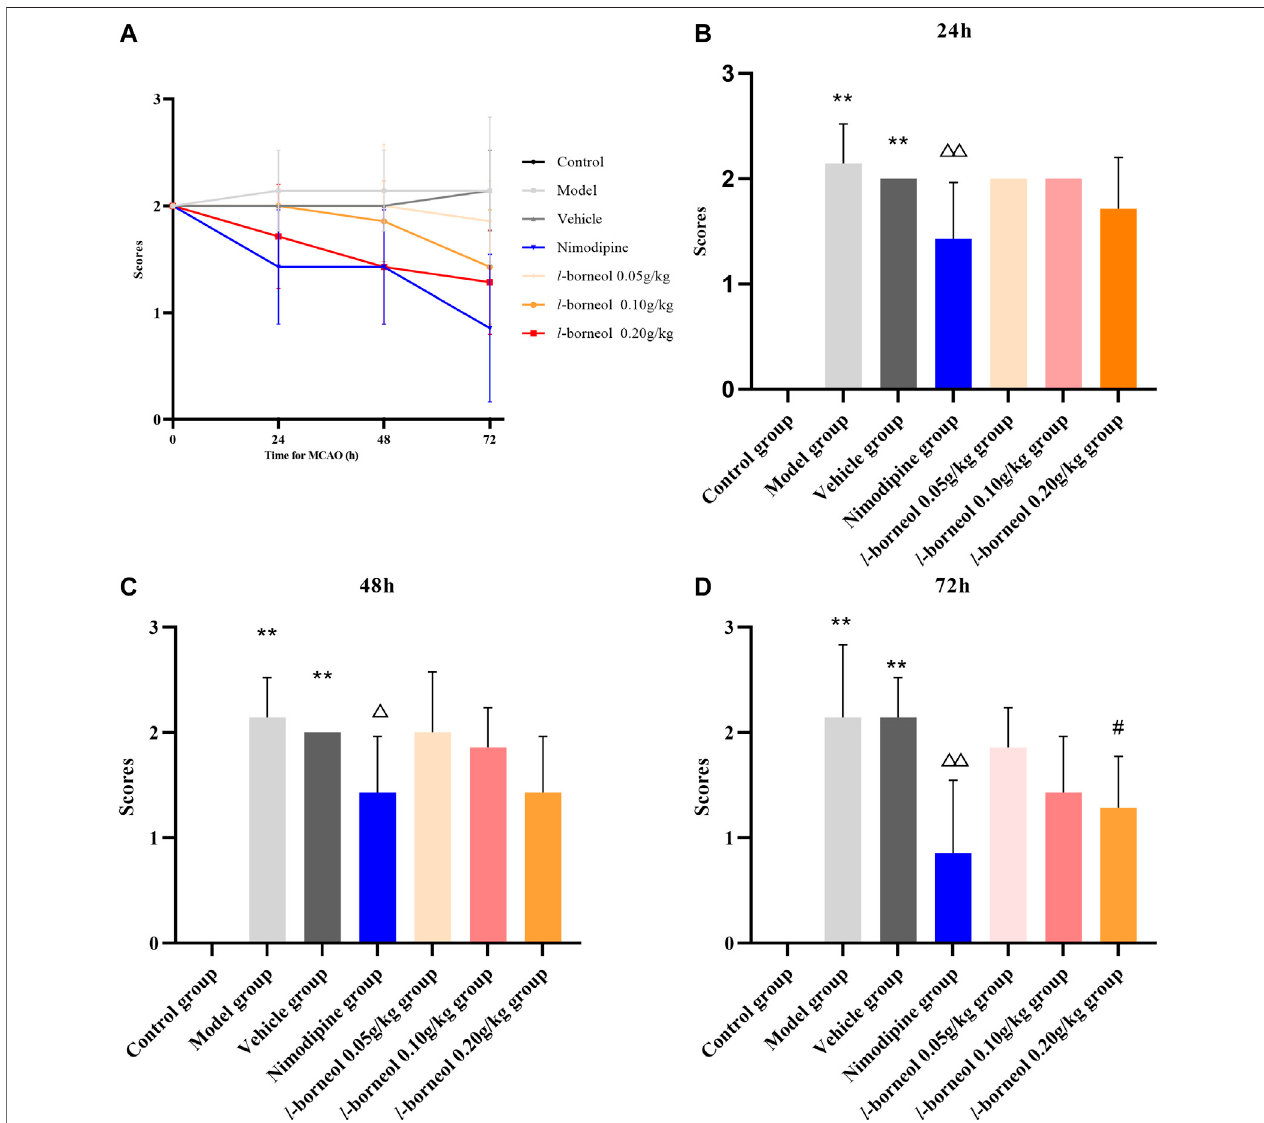
FIGURE 2 | Illustration of neurological function score using Zea – Longa methods ( n (cid:2) 6). (A) the trend after MCAO; (B) neurological function score after 24h; (C) neurological function score after 48h; (D) neurological function score after 72 h. ** p < 0.01, compared with the control group; △ p < 0.05, △△ p < 0.01, compared with the model group; # p < 0.05, compared with the vehicle